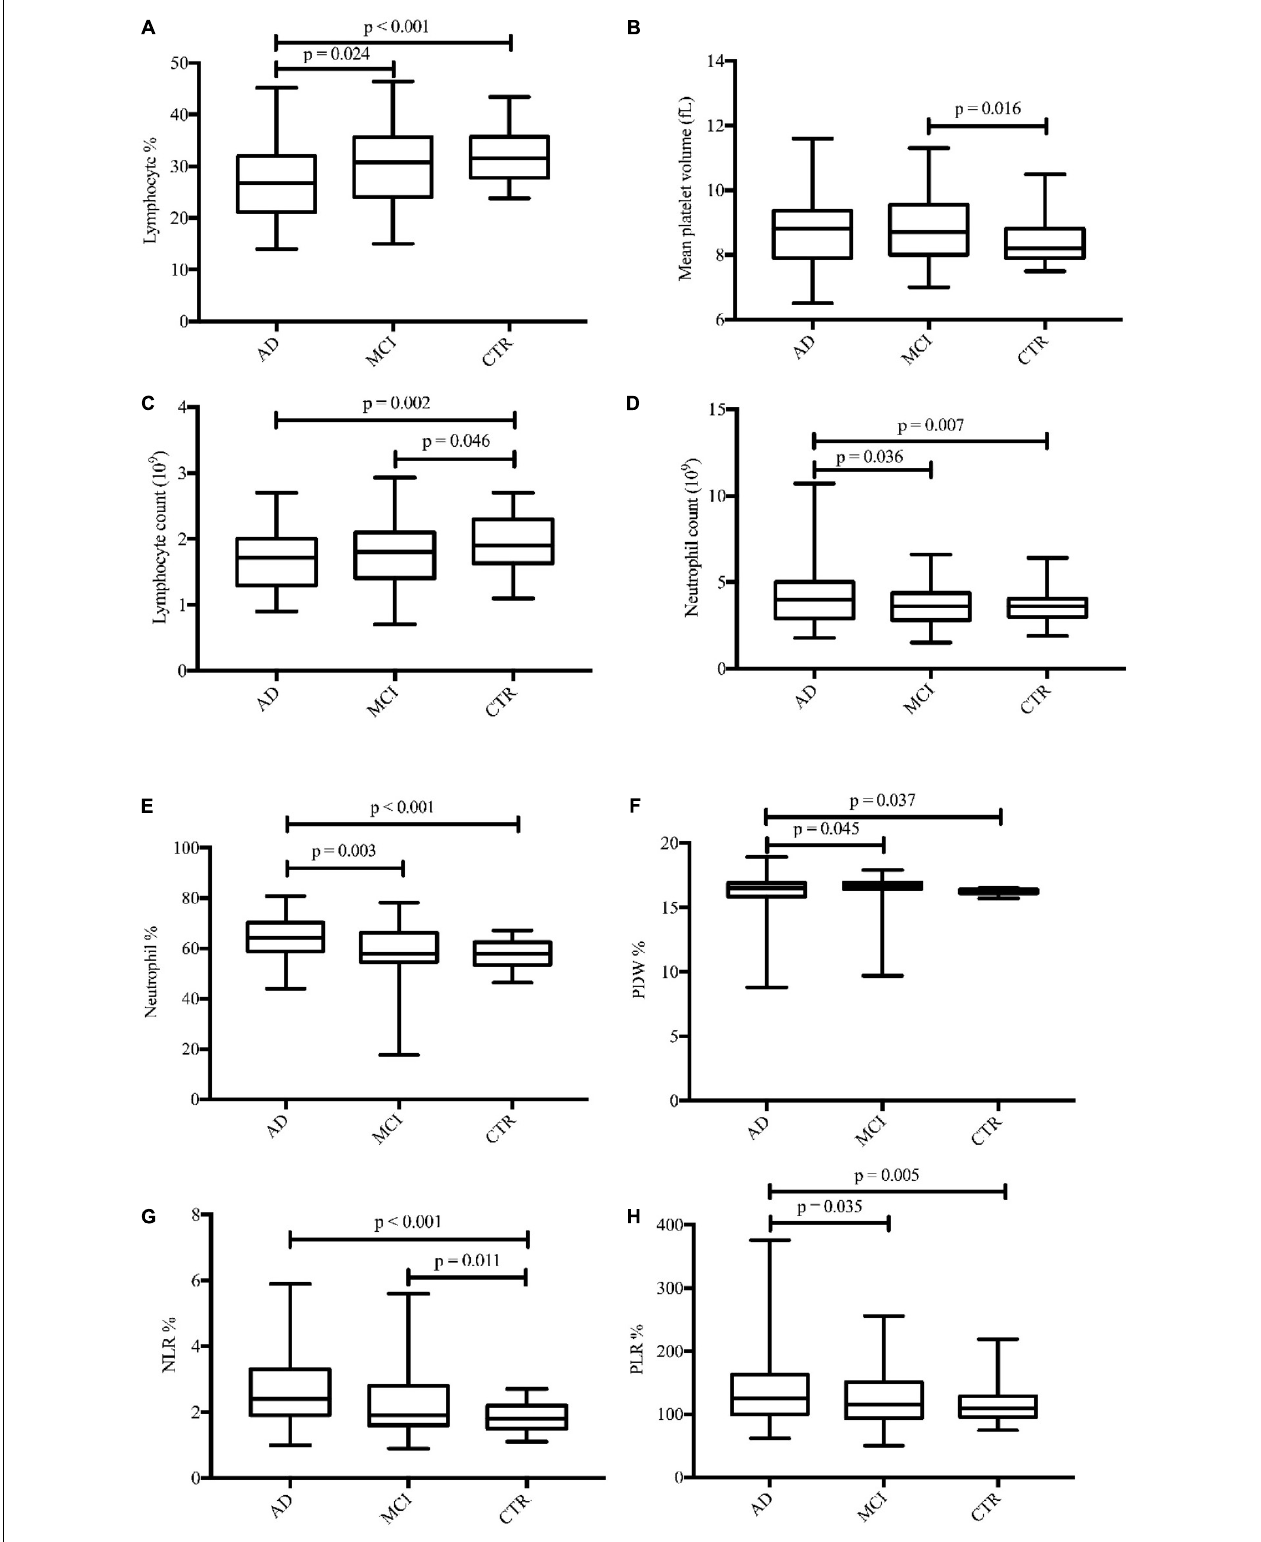
FIGURE 1 | Boxplots for the eight parameters (A–H) with significant differences in concentrations between diagnostic groups. AD, Alzheimer’s disease; MCI, mild cognitive impairment; CTRs, controls; PDW, platelet distribution width; NLR, neutrophil-to-lymphocyte ratio; PLR, platelet-to-lymphocyte ratio.